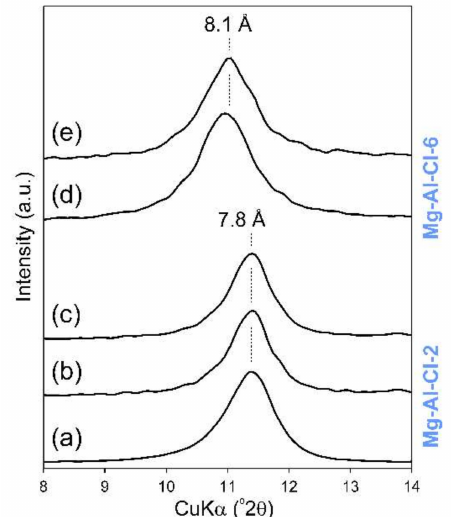
Figure 10. XRD patterns of selected LDH samples after reaction with FB1: ( a ) raw Mg-Al-Cl-2 sample, ( b ) FB1-treated Mg-Al-Cl-2 sample (pH 5, C FB1 100 ppm), ( c ) FB1-treated Mg-Al-Cl-2 sample (pH 7, C FB1 100 ppm), ( d ) raw Mg-Al-Cl-6 sample, and ( e ) FB1-treated Mg-Al-Cl-6 sample (pH 5, C FB1 200